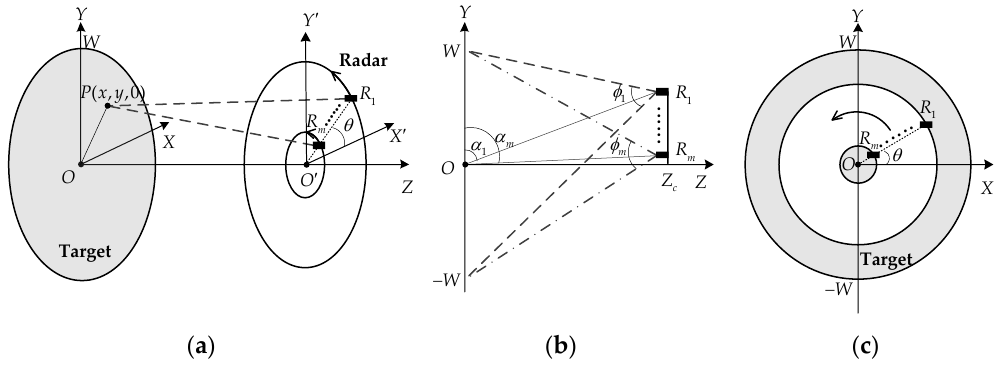
Figure 1. Observation geometry of the proposed imaging method : ( a ) Perspective view; ( b ) Front view; ( c ) Right side view.